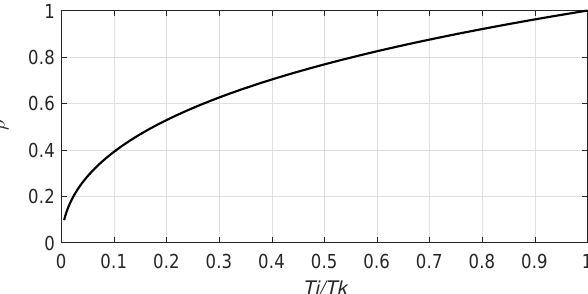
Figure 2. Evaluation of ρ solution in Equation (25) for T i / T k